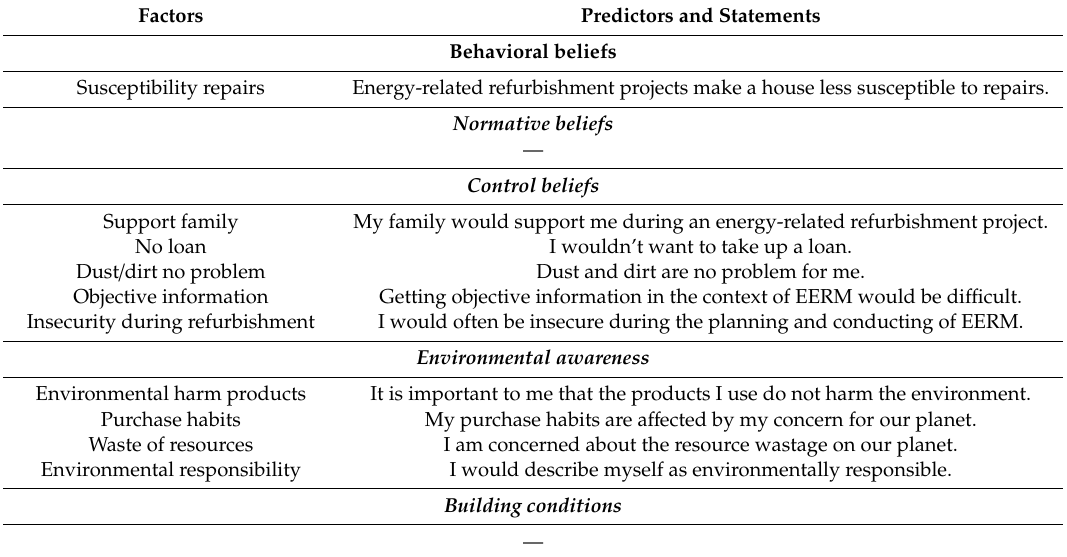
Table 3. Excluded factors /